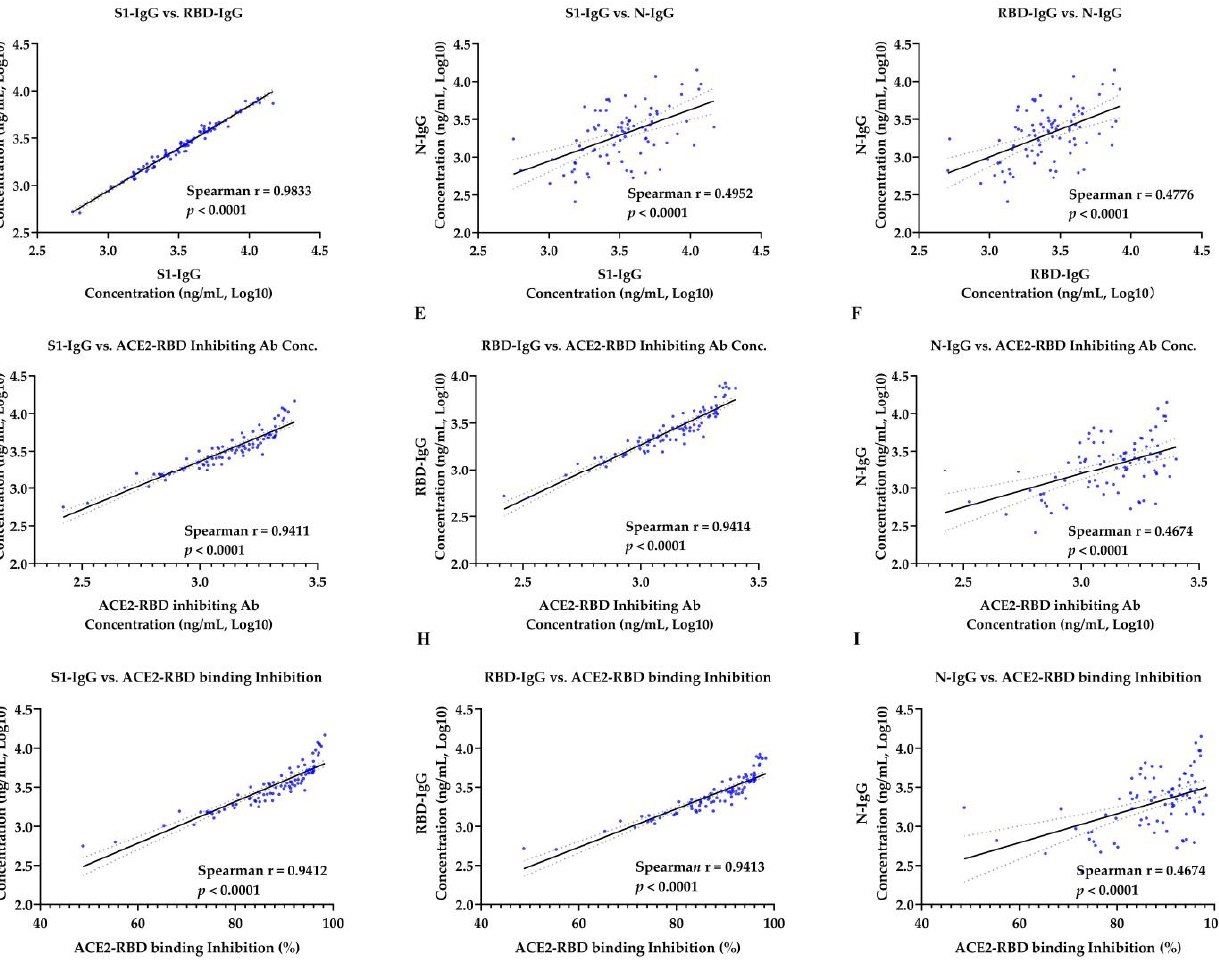
Figure 4. Correlation of ACE2-RBD inhibition assay and SARS-CoV-2 specific IgG concentration tests in 86 vaccinated samples. ( A ) Correlation of S1-IgG and RBD-IgG. ( B ) Correlation of S1-IgG and N-IgG. ( C ) Correlation of RBD-IgG and N-IgG. ( D – F ) Correlation of ACE2-RBD inhibiting antibody concentration and S1-IgG, RBD-IgG, and N-IgG. ( G – I ) Correlation of ACE2-RBD binding inhibition were computed by nonparametric spearman correlation. Spearman r > 0.7 and p value < 0.05 indicate a strong correlation, Spearman r < 0.7 and p value < 0.05 indicate a weak correlation, while p value > 0.05 indicate no correlation. The solid line represents a linear regression, with 95% confidence intervals represented by dotted lines. Table 3. The consistency analysis of chemiluminescence Immunoassays and microneutralization rest